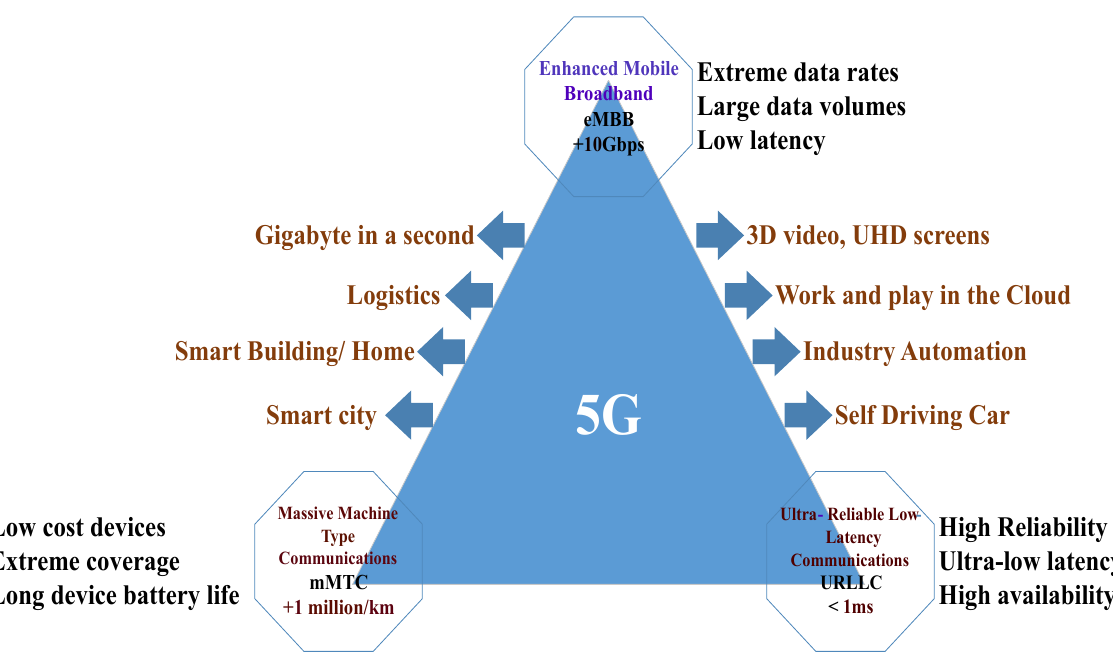
Figure 1. Features and improvement plan for future